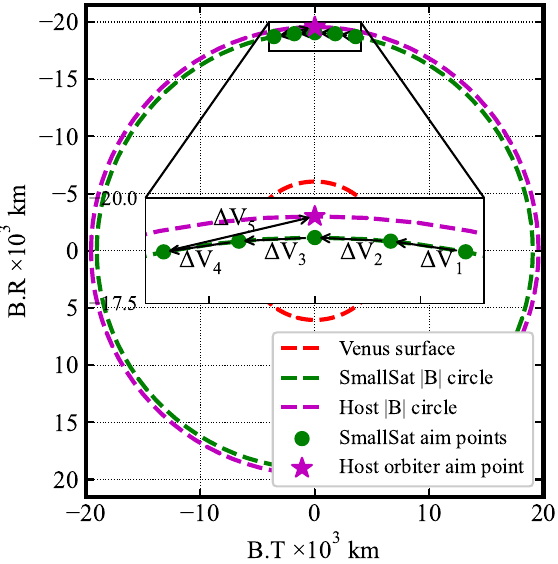
Figure 29. SmallSat and host orbiter aim points on the Venus B-plane. After releasing each SmallSat, the host orbiter performs a maneuver to target the aim point for the next